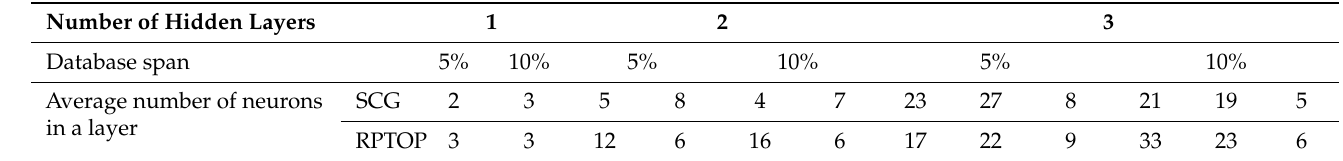
algorithms and different database